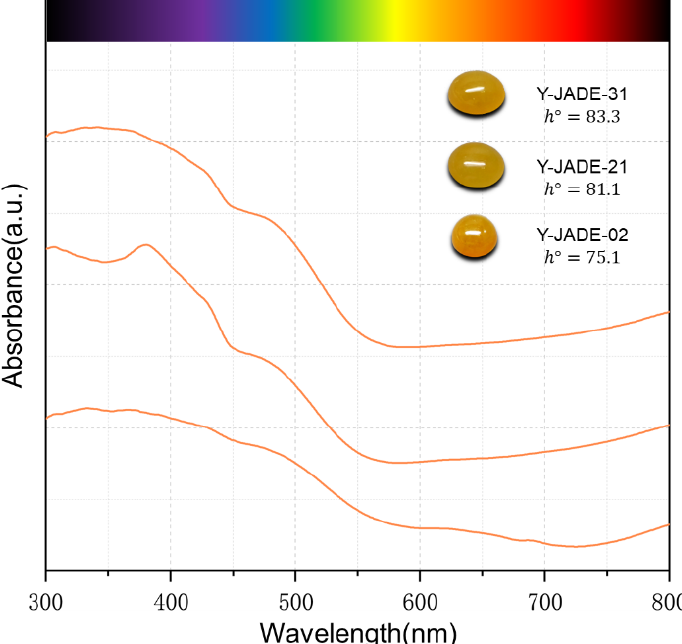
Figure 3. The UV-Vis spectrum conforms to the absorption of Fe 3+ oxides and